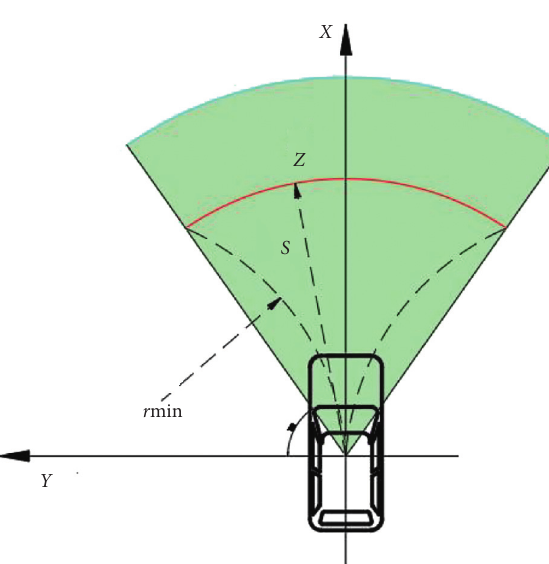
Figure 15: The active region of autonomous vehicle.